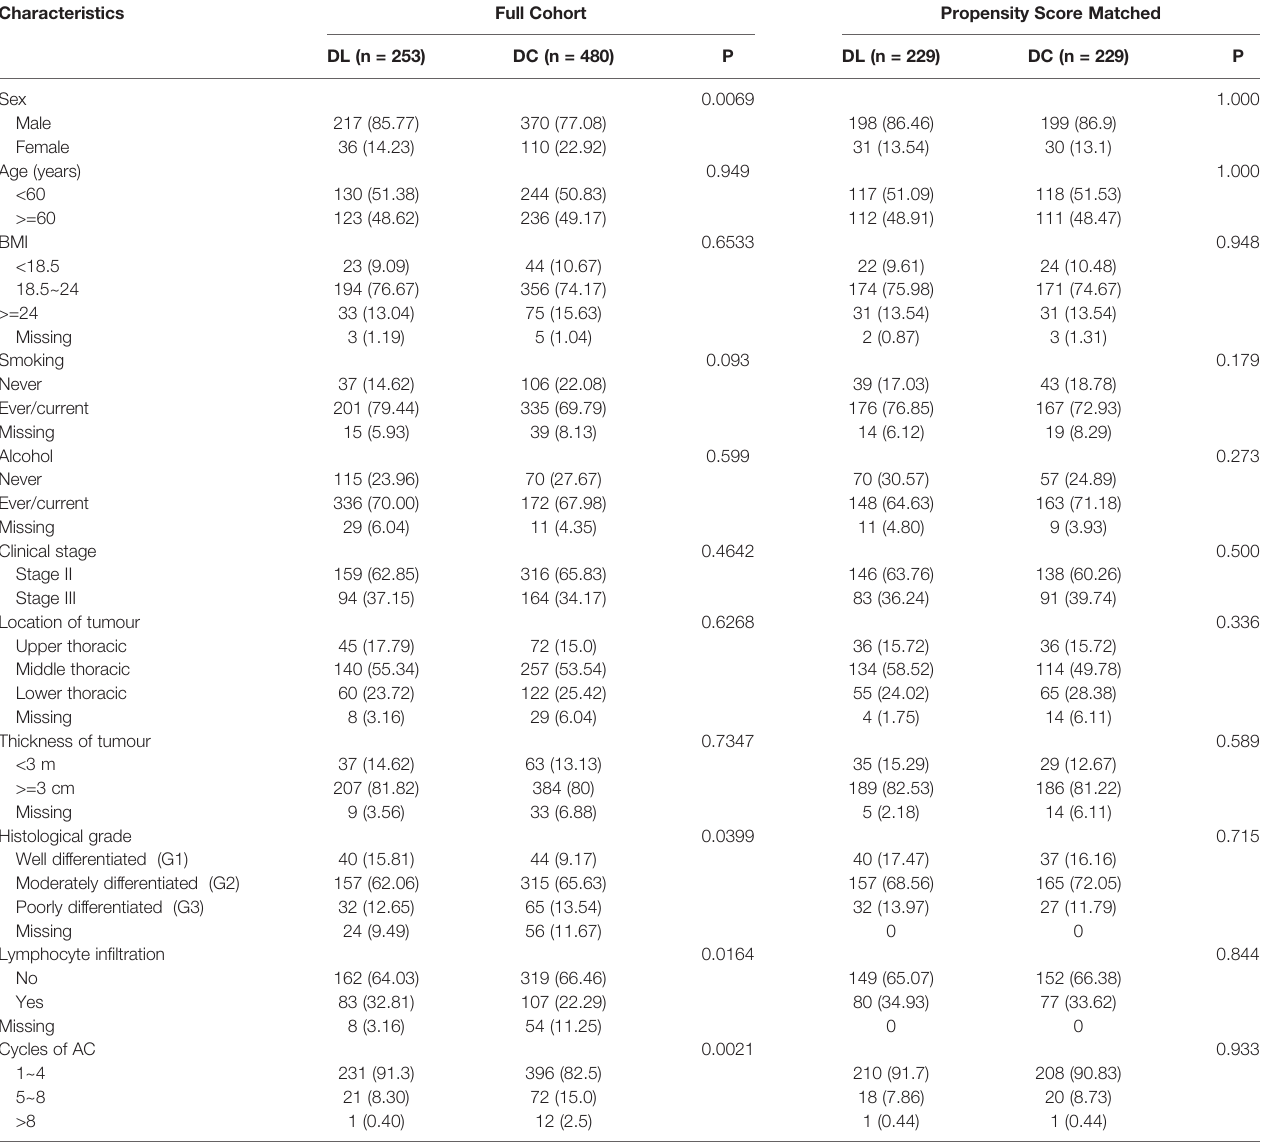
TABLE 1 | Characteristics of full and propensity score – matched cohorts.